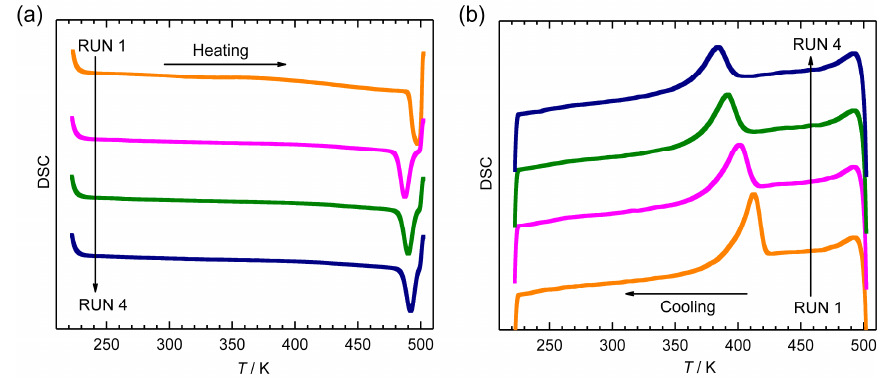
Figure 7. Differential scanning calorimetry (DSC) curves of 1·AsF 6 in the heating mode ( a ) and cooling mode ( b ) recorded over four successive thermal cycles at a sweep rate of 10 K·min − 1 , in the temperature range of 222–502 K. Orange: first cycle; magenta: second cycle; olive: third cycle; navy blue: fourth cycle.